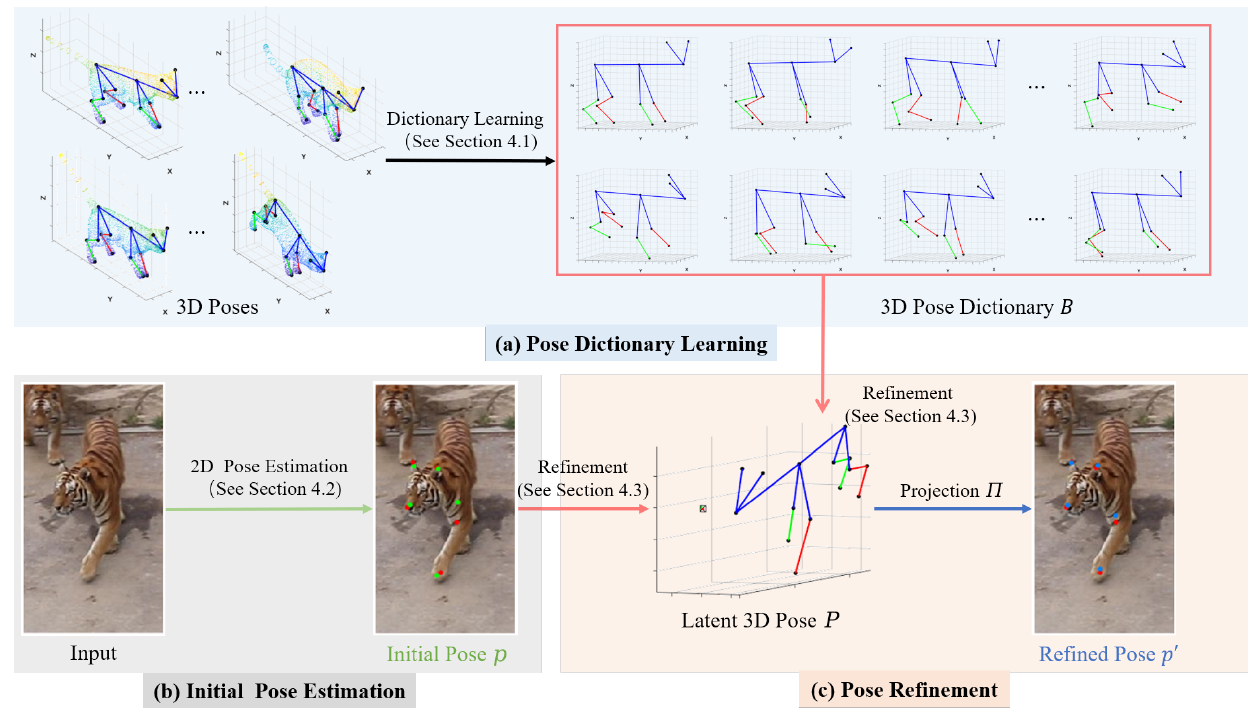
Figure 4. Overview: ( a ) we constructed a 3D pose dataset (as described in Section 3.1) to learn a 3D pose dictionary B , which was used to provide 3D prior constraints; ( b ) in the pose estimation stage, the 2D pose p corresponding to the image was initially estimated using existing algorithms; ( c ) refinement was performed by combining the initial pose p and the 3D constraints provided by the 3D pose dictionary B , resulting in a more accurate 2D pose p (cid:48) . In ( b , c ), the blue, red and green lines indicate the connections between the joints on the trunk, left limb and right limb,